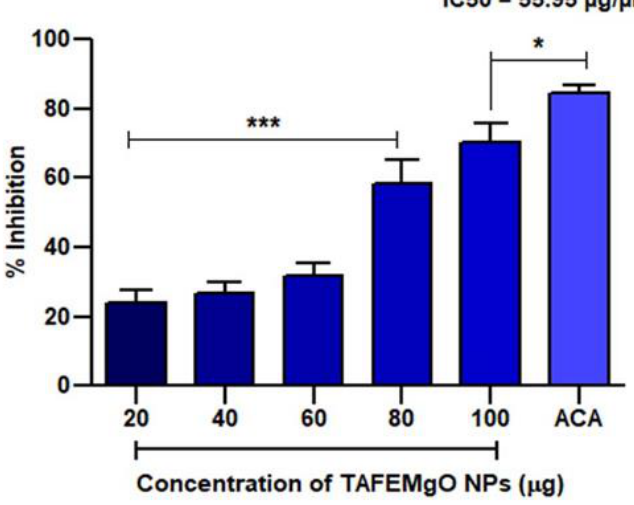
Figure 3. TAFEMgO NPs DPPH-scavenging activity. The DPPH technique was employed to predict the antioxidant potential of TAFEMgO NPs. Each value is given as a mean ± SD. * Significance at p ≤ 0.005 and *** at p ≤ 0.001.